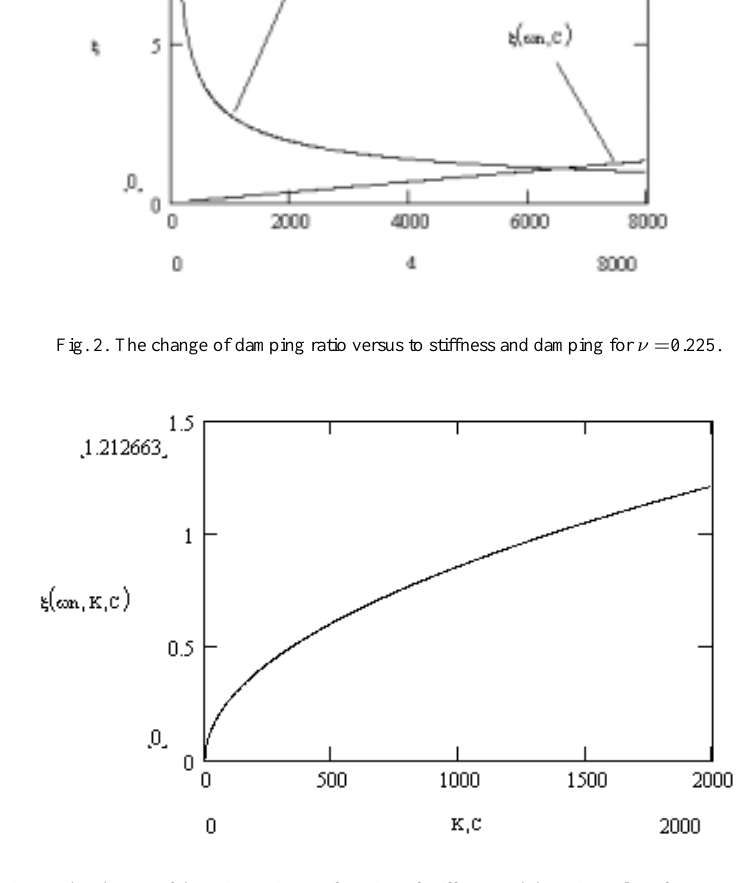
Fig. 3. The change of damping ratio as a function of stiffness and damping values for ν =